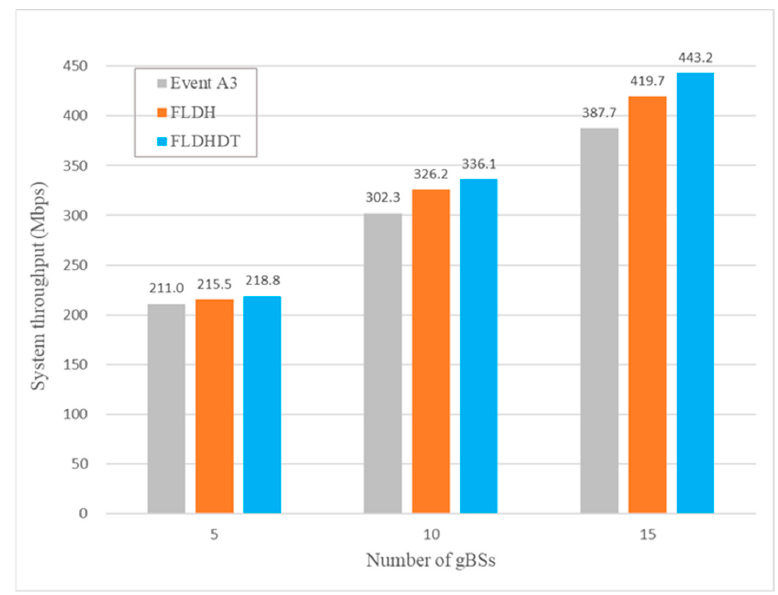
Figure 12. Ping-pong ratio versus number of gNBs.